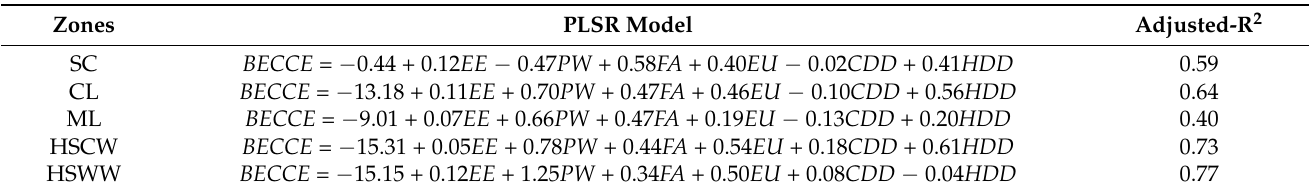
Table 1. PLSR models of the 5 zones.